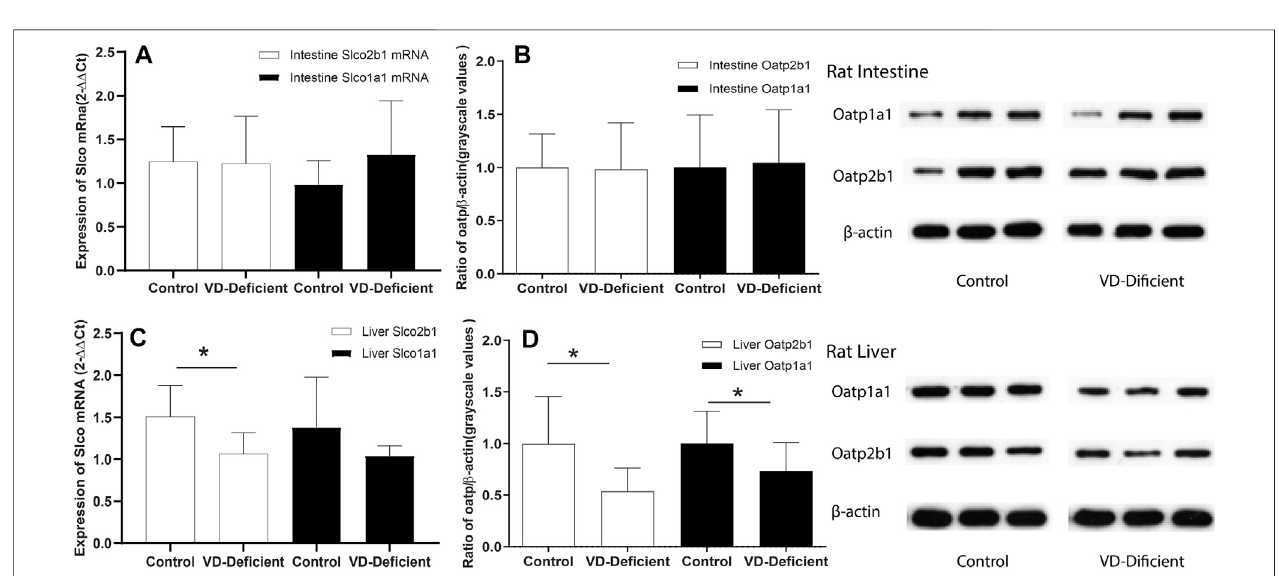
FIGURE5| EffectsofVDde fi ciencyontheOatpsmRNAandproteinexpressionsinrattissues. (A) Slco2b1andSlco1a1mRNAexpression(normalizedby β -actin) in the rat intestine. (B) Oatp2b1 and Oatp1a1 protein expression in the rat intestine. (C) Slco2b1 and Slco1a1 mRNA expression (normalized by β -actin) in rat liver. (D) Oatp2b1 and Oatp1a1 protein expression in rat liver. VD de fi ciency can down-regulate Oatps expression in the liver but has no signi fi cant effect in the small intestine. 2 − △△ Ct andgrayscalevalueswereusedtocomparegenesandproteinexpressionsbetweenthegroups,respectively,and β -actinwasusedasthereferencegene. Control group: rats fed on a VD-supplement diet ( n = 6), 25(OH)VD concentration is 20 – 100 ng/ml, VD-de fi cient: rats fed on a VD-free diet ( n = 9), 25(OH)VD concentration is < 20 ng/ml * p < 0.05: statistically signi fi cant difference, using two-tailed unpaired t-test.